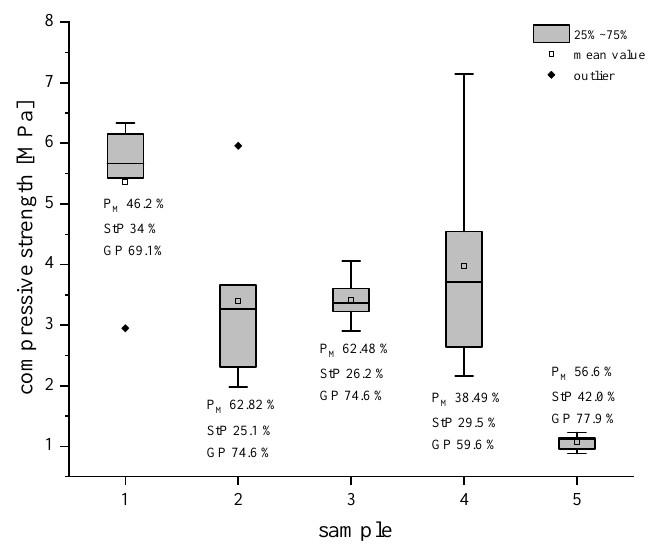
Figure 5. Compressive strengths of Freeze Foam specimen including mean value, outliers, and standard